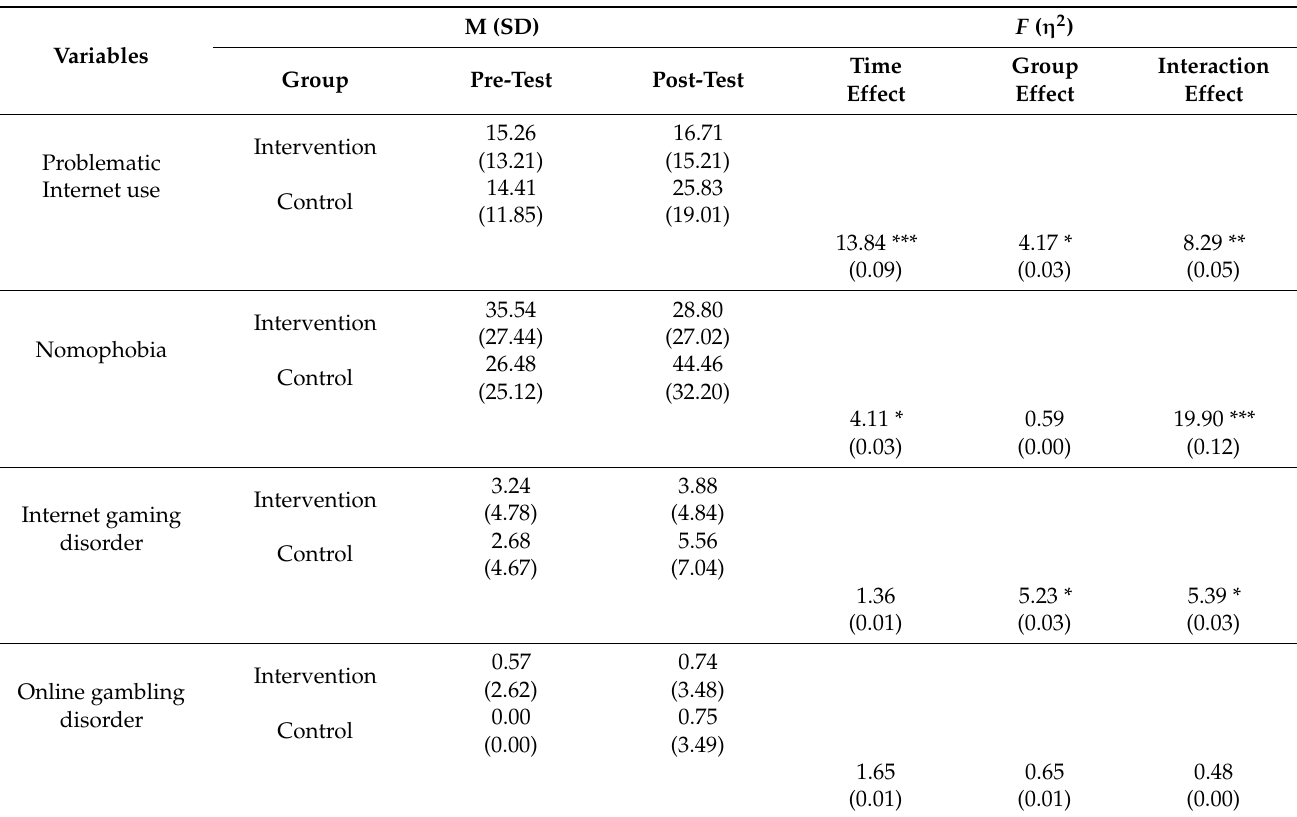
Table 4. Intergroup effects and repeated measures analysis of variance (ANOVA 2 × 2) in dysfunctional Internet risks.